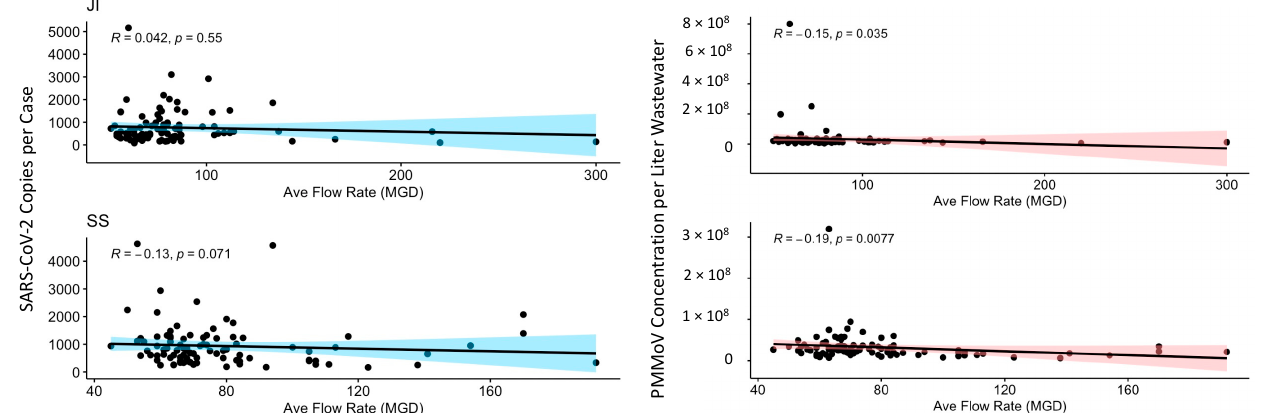
Figure 5. Kendall’s rank correlation of case-adjusted concentration (copies/L/case) ( left ) and PMMoV Figure 5. Kendall ’ s rank correlation of case-adjusted concentration (copies/L/case) (left) and concentration ( right ) to daily average flow rate (MGD) in JI ( top ) and SS ( bottom ). PMMoV concentration (right) to daily average flow rate (MGD) in JI (top) and SS (bottom).